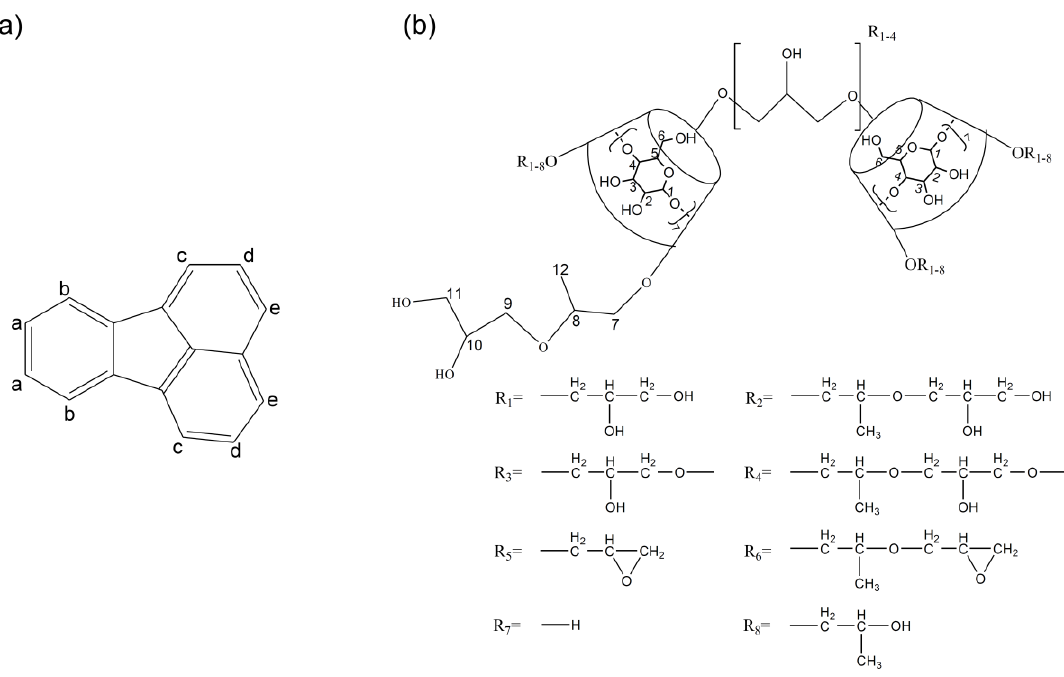
Figure 1. Chemical structure of ( a ) FT and ( b ) HP- β -CD-ol. Figure 1 . Chemical structure of ( a ) FT and ( b ) HP-β-CD-ol. Figure 1 . Chemical structure of ( a ) FT and ( b ) HP-β-CD-ol.